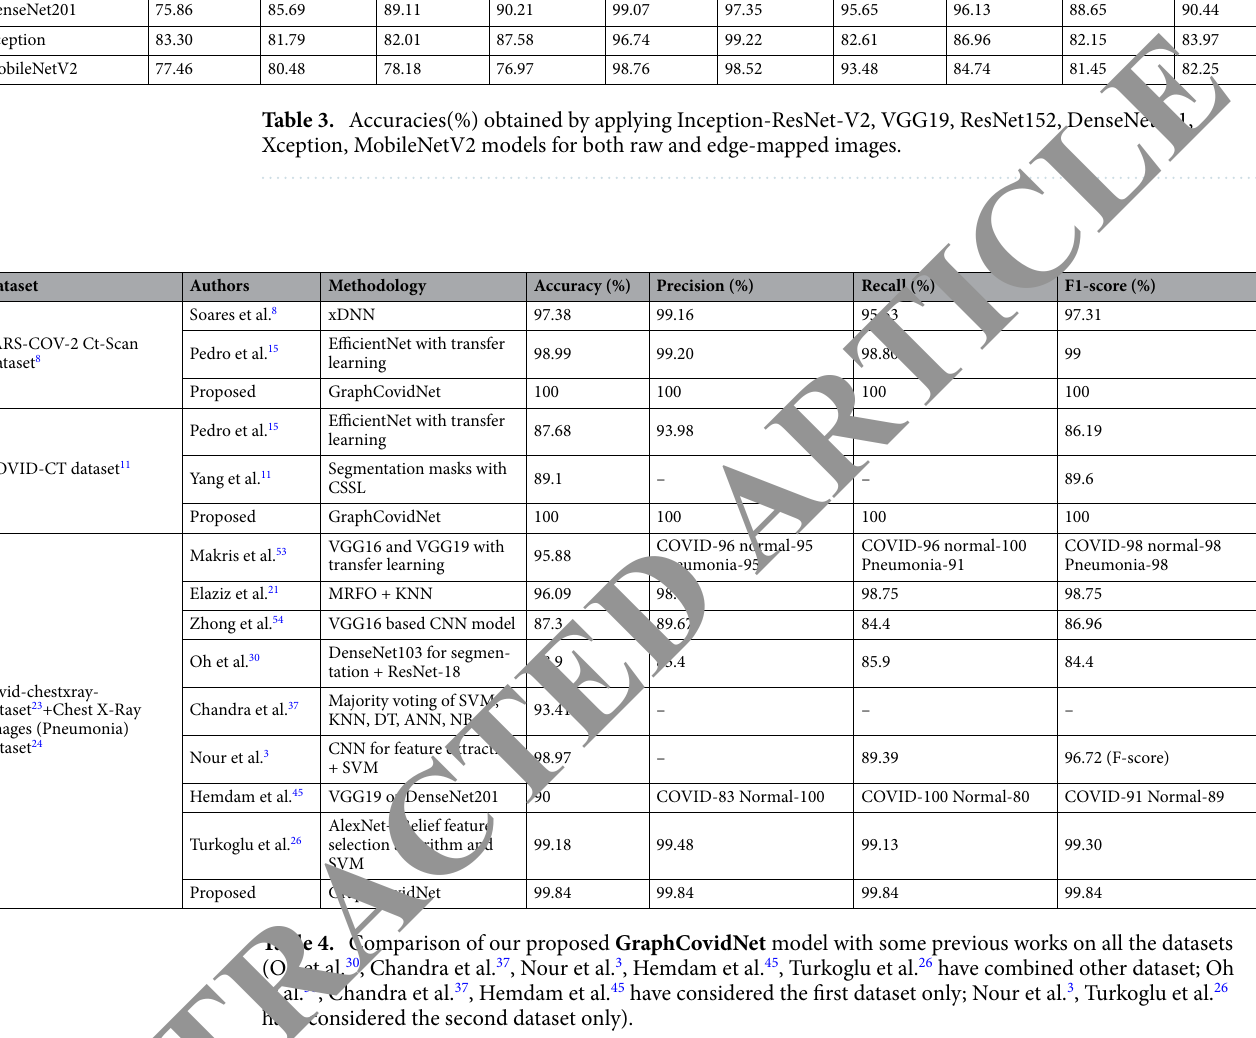
Table 4. Comparison of our proposed GraphCovidNet model with some previous works on all the datasets (Oh et al. 30 , Chandra et al. 37 , Nour et al. 3 , Hemdam et al. 45 , Turkoglu et al. 26 have combined other dataset; Oh et al. 30 , Chandra et al. 37 , Hemdam et al. 45 have considered the first dataset only; Nour et al. 3 , Turkoglu et al. 26 have considered the second dataset only).